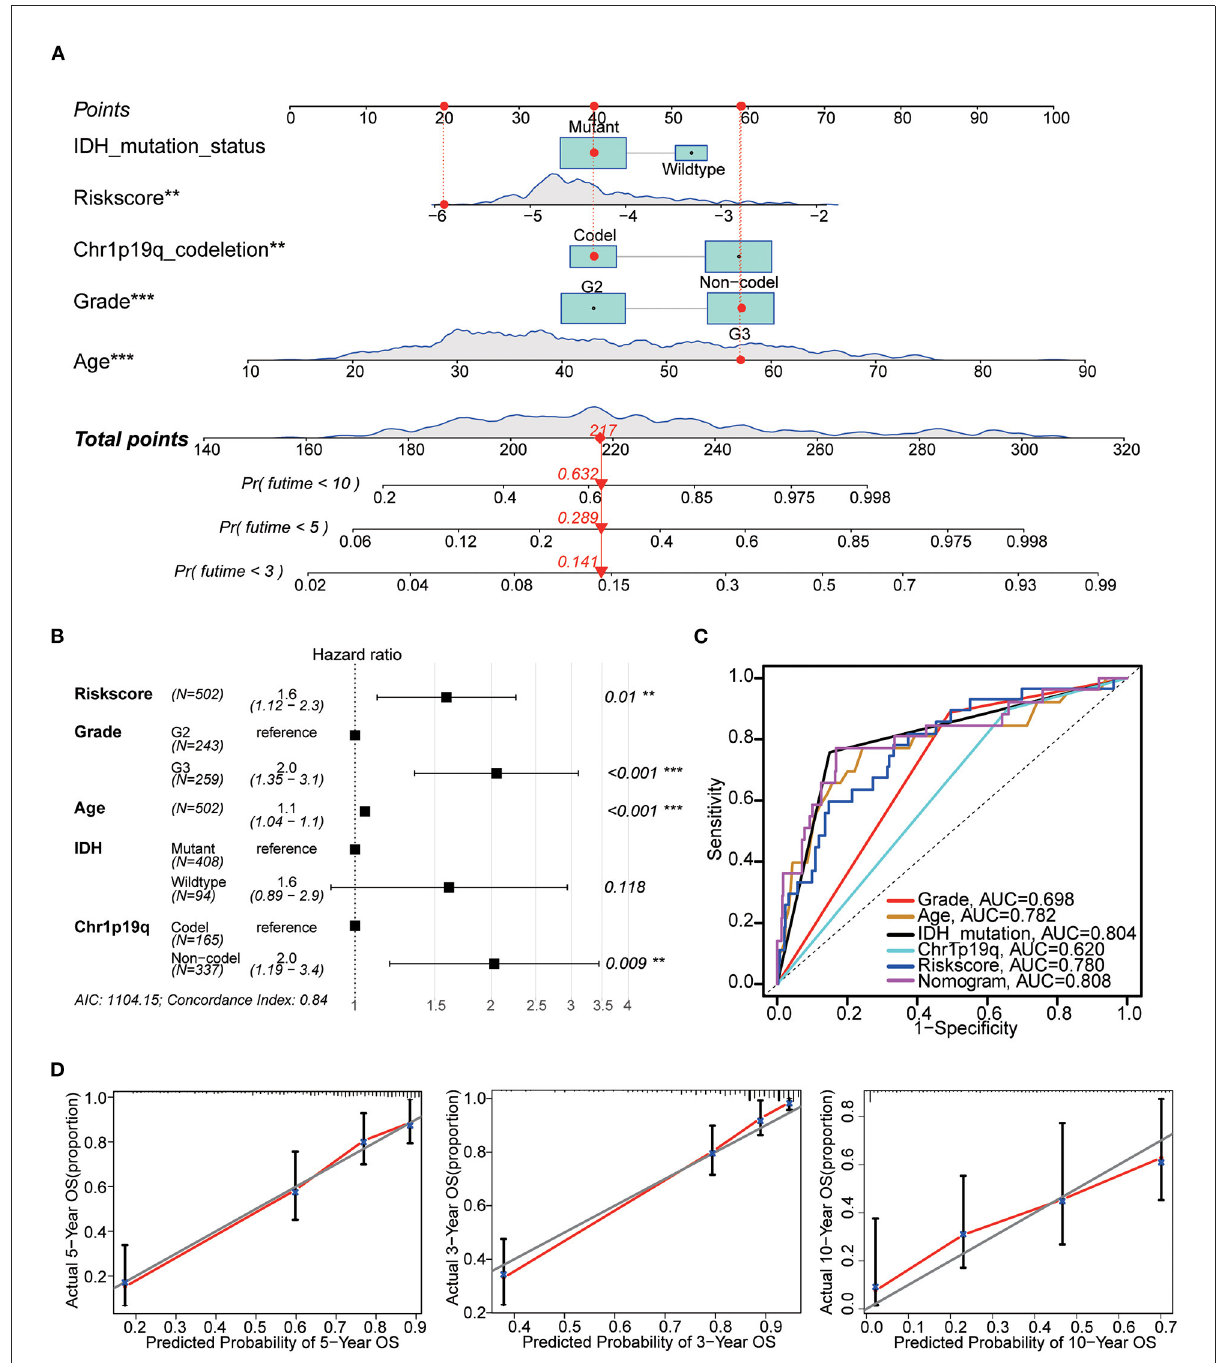
FIGURE9 Nomogram construction. (A) The nomogram used risk score, age, grade, IDH mutation and 1p19q co-deletion to assess the 3, 5, and 10-year overall survival of LGG. (B) Hazards ratio, p value and 95% CI of each variable in the nomogram model. Model’s AIC value and c-index are at the bottom. (C) Multivariate ROC analysis was used to compare the predictive power of each variable. Among them, the nomogram has the best predictive ability. (D) The calibration curve for the evaluation of the nomogram. The Y-axis designates the actual survival, while the X-axis designates nomogram estimated 3, 5, and 10-year OS of patients in TCGA cohort. ** p < 0.01, *** p <